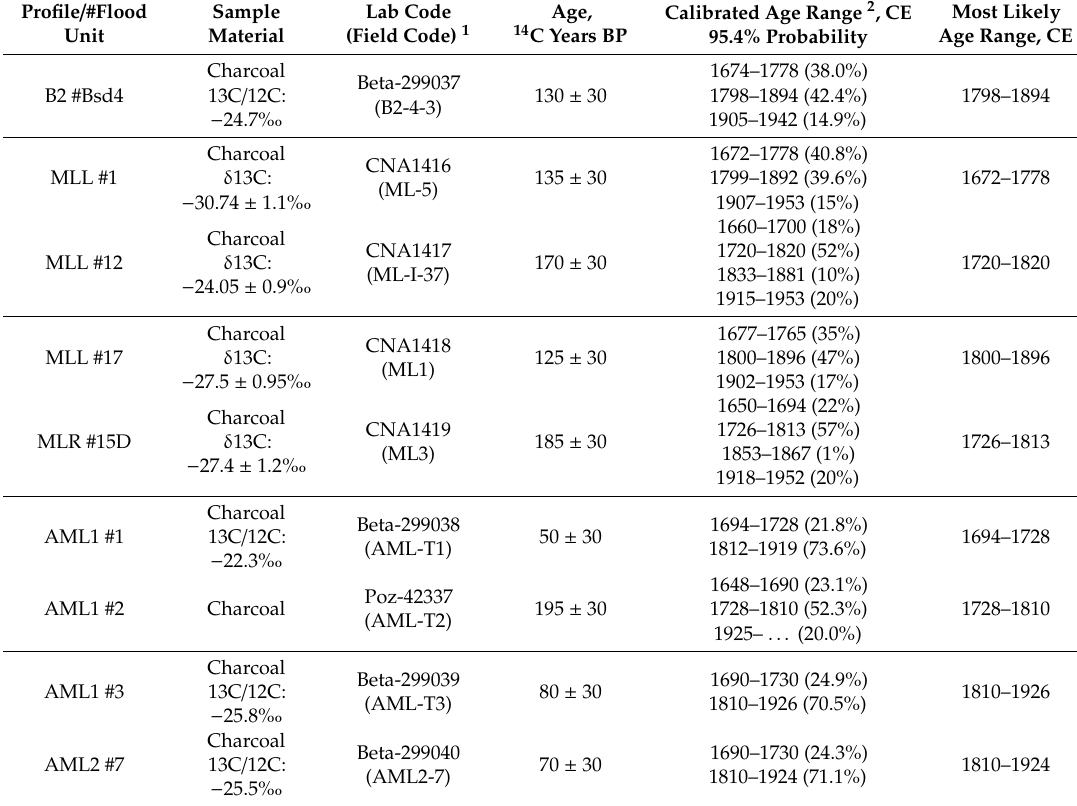
Table 1. Radiocarbon dating with indication of stratigraphic profile and unit